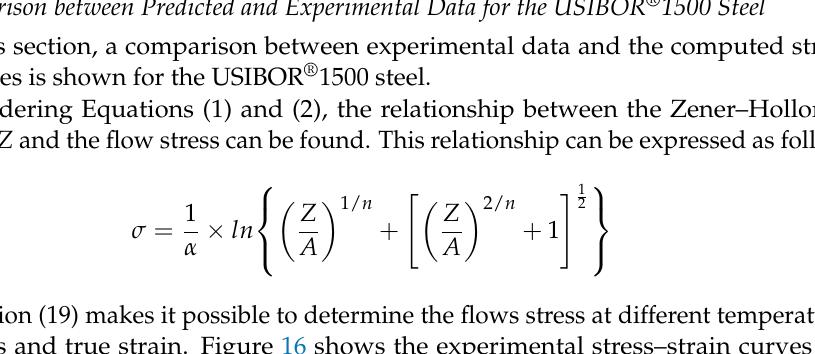
Figure 15. Comparison with literature data [11,15,16] on the polynomial fitting curves of material coefficients as a function of strain: ( a ) for 𝛼 ( b ) 𝑛 , ( c ) 𝑄 , and ( d ) ln(𝐴) for the USIBOR ® 1500.